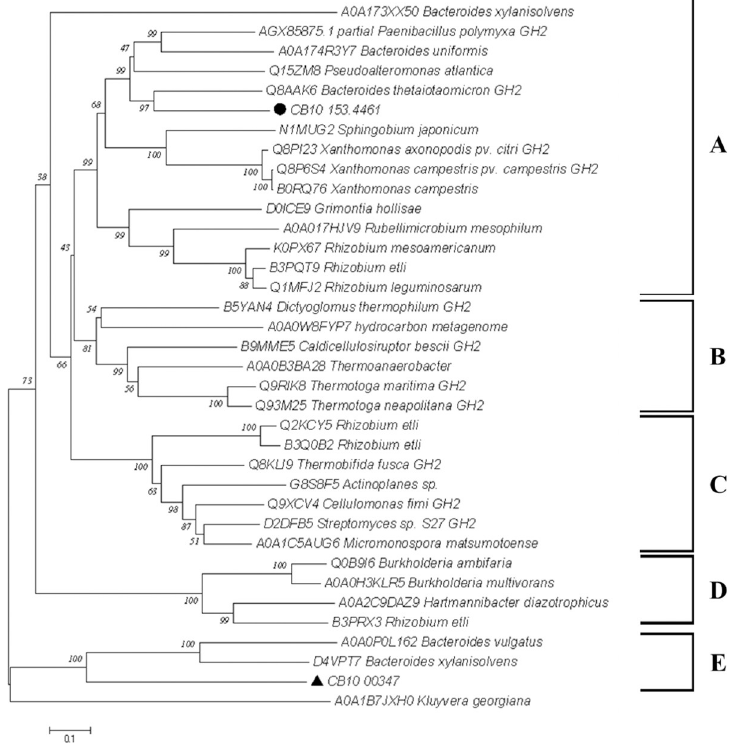
Fig 2. Phenetic dendrogram generated by the MEGA 5 program for β -mannosidases. The analysis was carried out based on the distance matrix generated from an alignment made by the T-coffee, using the Neighbor Joining clustering optimization method [47]. The percentage of replicate trees in which the associated taxa clustered together in the bootstrap test (10,000 replicates) is shown next to the branches [48]. The tree is drawn to scale, with branch lengths in the same units, based on similarity; distances were computed using the Poisson correction method [49] and are in the units of the number of amino acid substitutions per site. The analysis involved 36 amino acid sequences. All positions containing gaps and missing data were eliminated. There was a total of 330 positions in the final dataset. The tree was conducted in MEGA7 [39]. Circle and Triangle: respectively, β -mannosidases CB10-153.446 and CB10-00347.